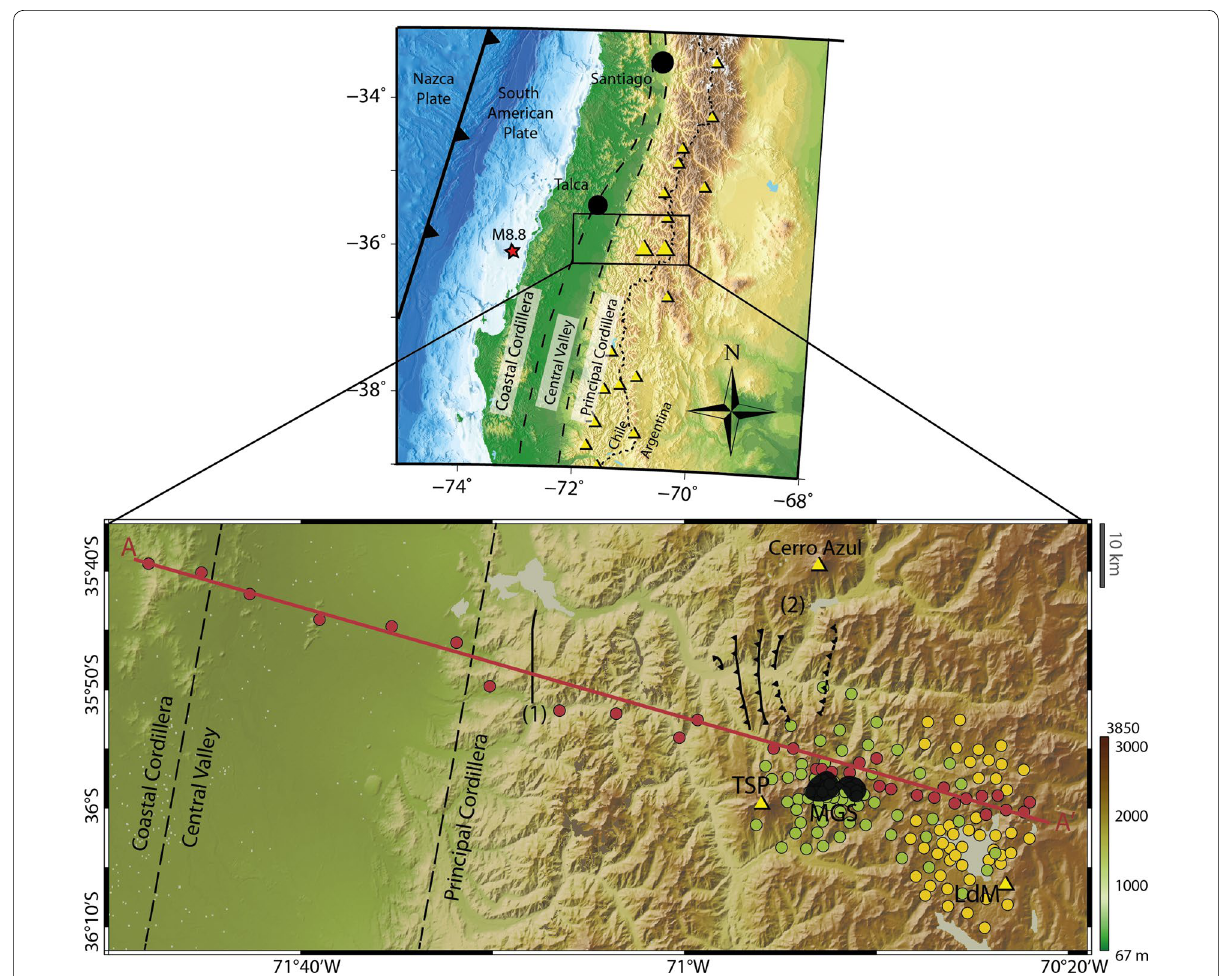
Fig. 1 Study area. A regional map shows the morphostructural units delimited by black dashed lines and volcanoes are represented by yellow triangles, the volcanic arc is defined by the location of these volcanoes. The location of the 2010 M8.8 Maule earthquake epicenter is shown as a red star. A map inset shows the MT study area. Broadband MT stations are shown in circles: green represents those measured by Alterra Power (2009–2012), yellow by Universidad de Chile and University of Alberta (2015–2016). The red circles are the stations used in the 2D inversion. The profile used in the 2D inversion is denoted by AA ′ . MGS is delimited in black by the MT anomaly from Hickson et al. (2011). The faults shown are (1) fault mapped by Sernageomin (2003) using surface features and (2) reverse east‑verging faults, from west to east: García Fault, Las Corrientes Fault and Hornitos Fault (Astaburuaga